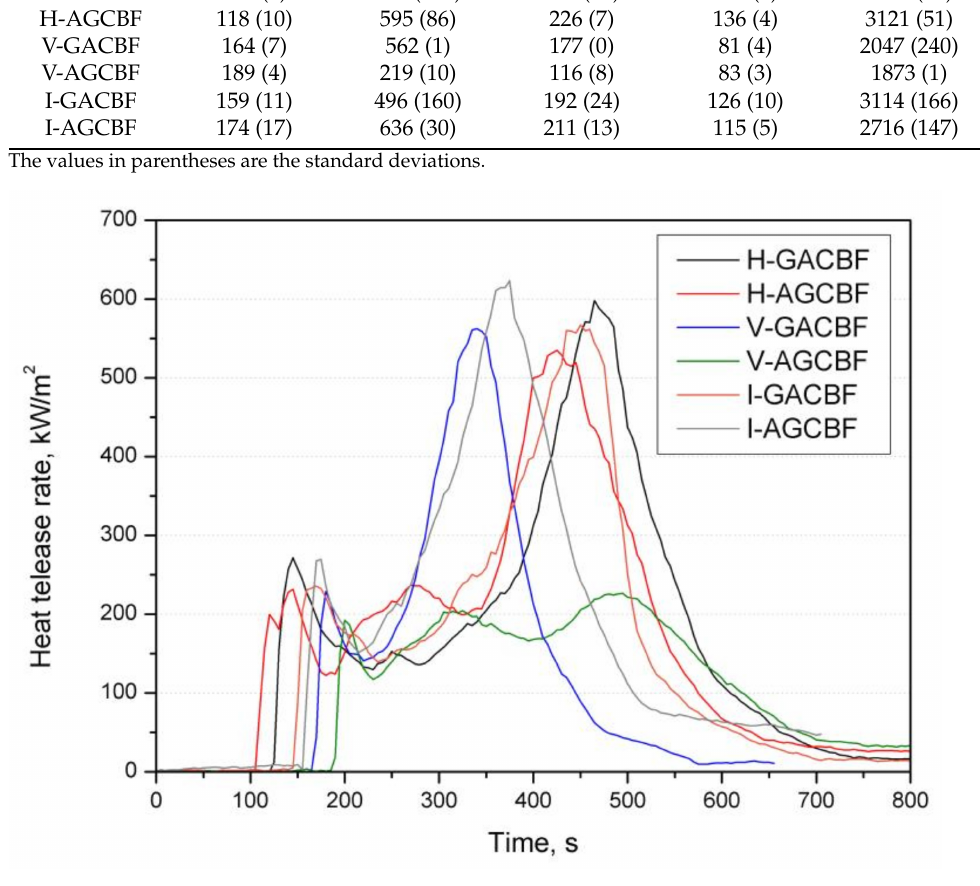
Figure 5. Representative curves of the heat release rate of the EP-based